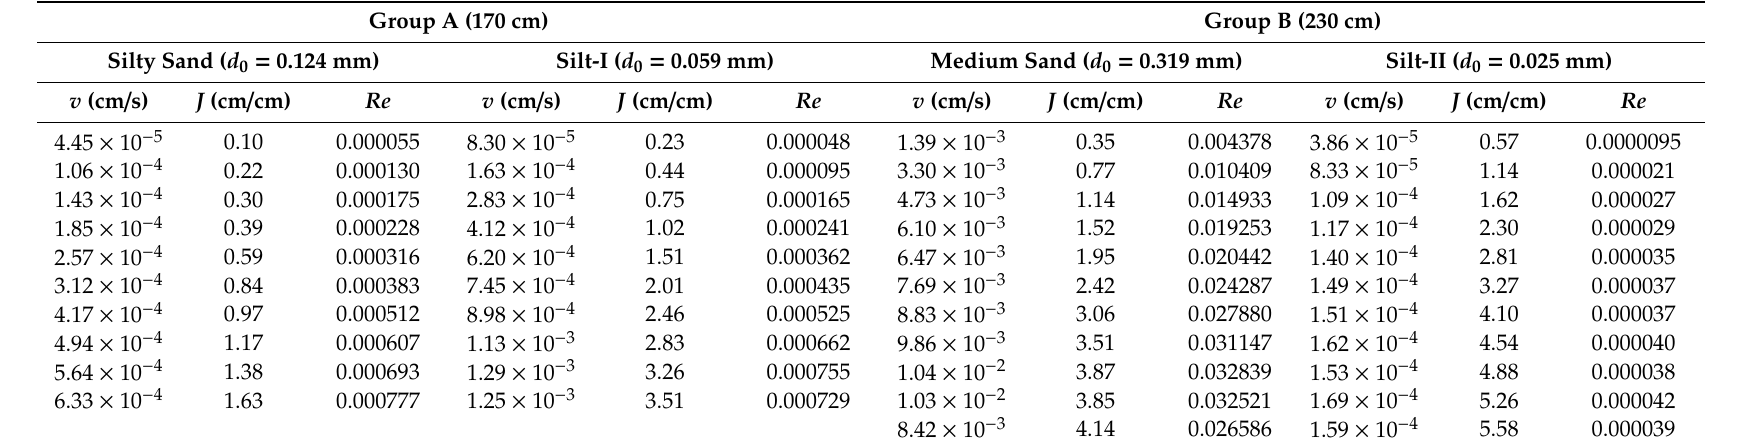
Table 2. Results of the four experimental